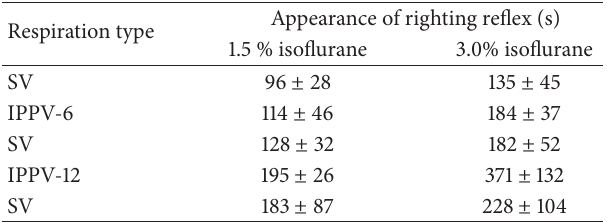
Table6:Mean ± SDfortimeittookfortherighting(recovery)reflex to appear after spontaneous (SV) or intermittent positive pressure ventilation (IPPV) in 6 sulphur-crested cockatoos ( Cacatua galerita galerita ) after 1.5% or 3.0% isoflurane anaesthesia.